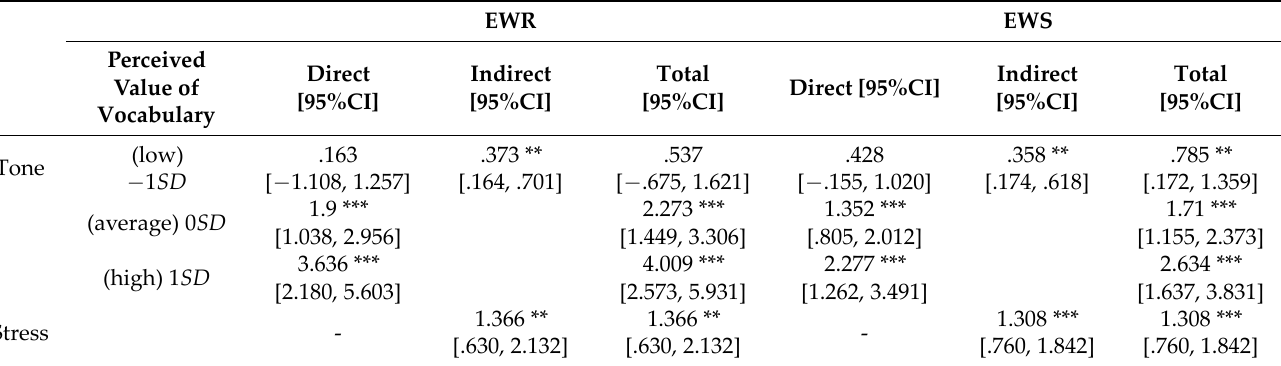
Figure 6. Performance of Grade 4 English word spelling predicted by Chinese tone perception at low, average, and high levels of oral vocabulary scores. The x‑axis depicts tone and the y‑axis represents English word reading performance at low ( − 1 SD), medium (0 SD), and high (+1 SD) levels of oral vocabulary. Table 7. Conditional Effects of Tone on English Word Reading and Word